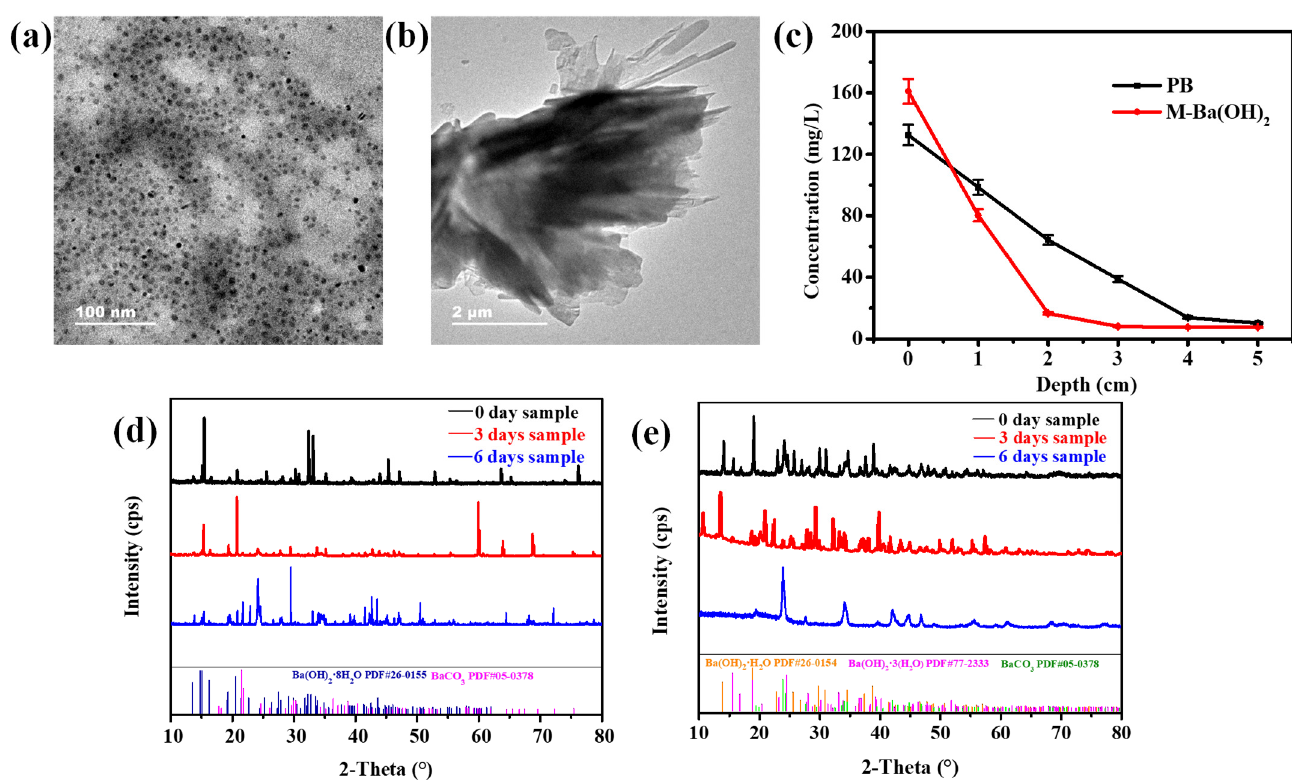
Figure 5. ( a ) TEM of N-Ba(OH) 2 nanoparticles; ( b ) TEM of M-Ba(OH) 2 particles; ( c ) penetration depth of barium ions after the black brick sample was left standing for 2 h; ( d ) XRD of M-Ba(OH) 2 at 0, 3, and 6 days; and ( e ) XRD of N-Ba(OH) 2 at 0, 3, and 6 days.